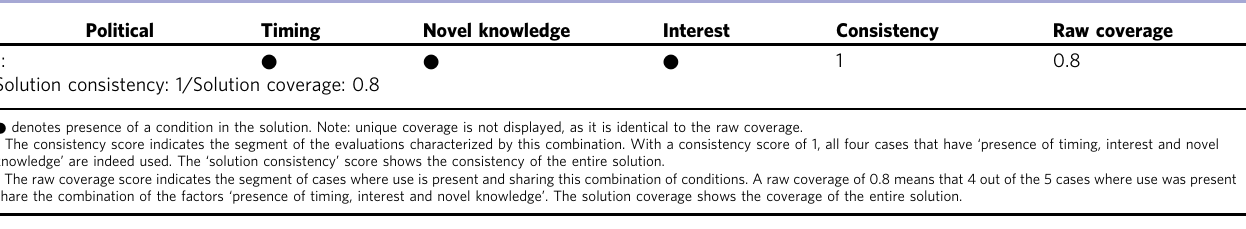
Table 4 Suf fi ciency analysis for the presence of use.